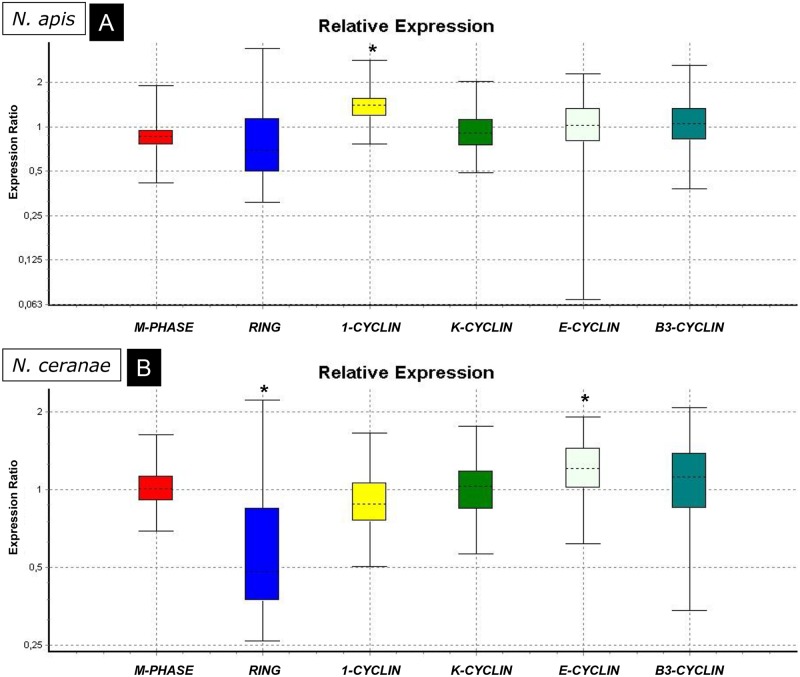
Relative expression ratio plots for genes related to the cell cycle.Analysis of the groups infected with N. apis (A) or N. ceranae (B) relative to the uninfected bees. (*) significant differences.